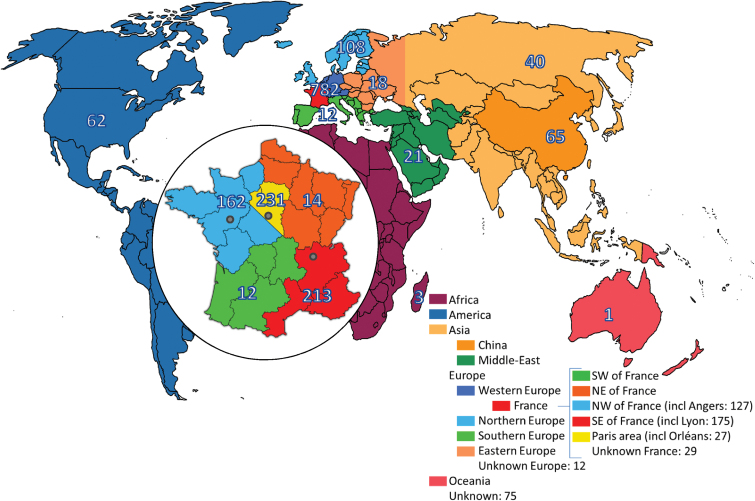
Areas of origin of the 1228 sampled roses. The number of roses from each region is displayed. In the circle, a focus is made on France.